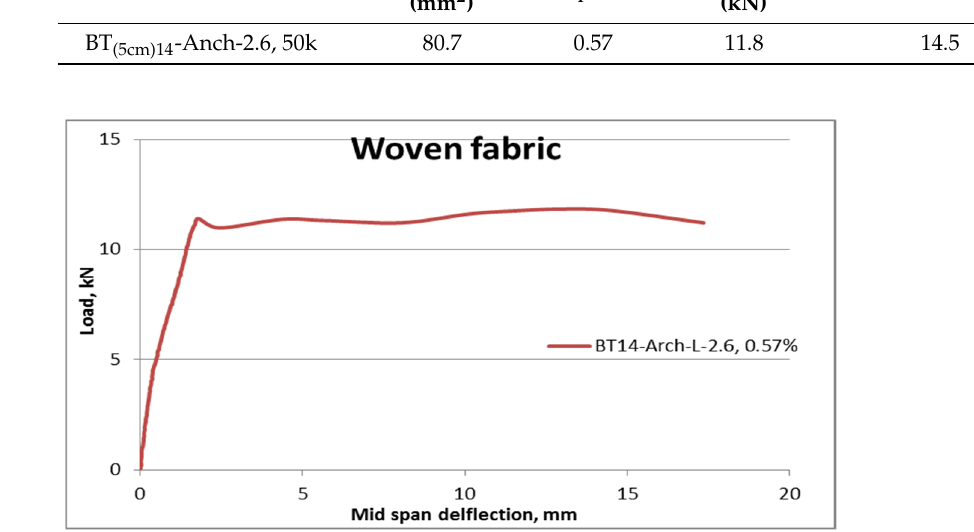
Figure 8. Mid-span load-deflection of large-scale bi-axial TRC beams.